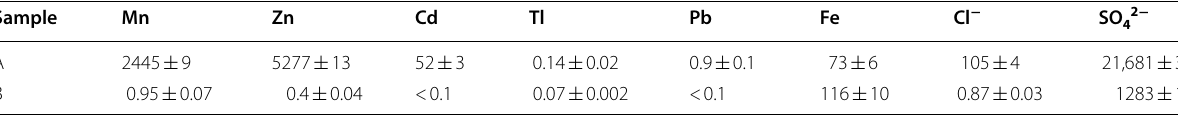
The results are presented as mean values